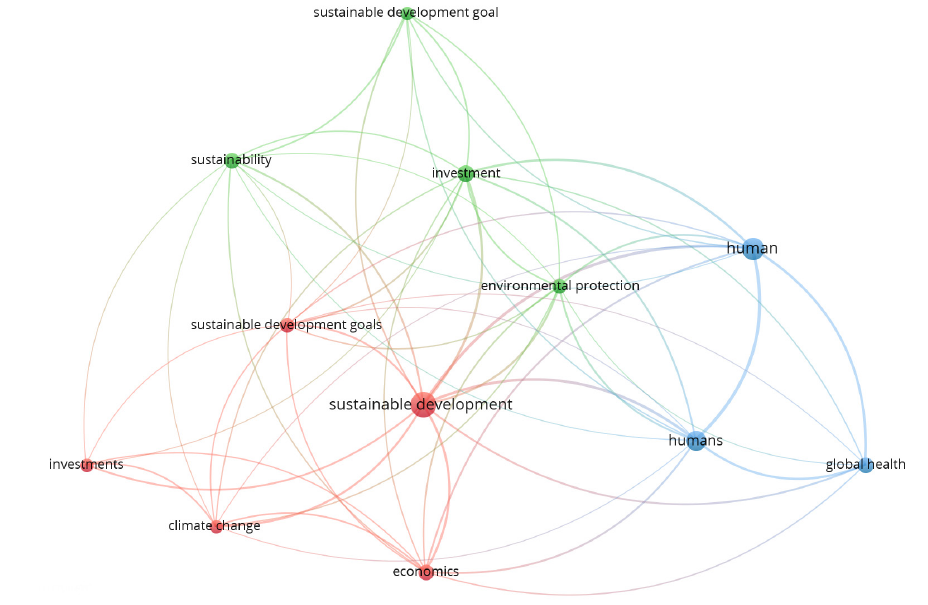
Figure 3. Bibliometric map of the publications concerning “SDG 3 and investment” and “SDG